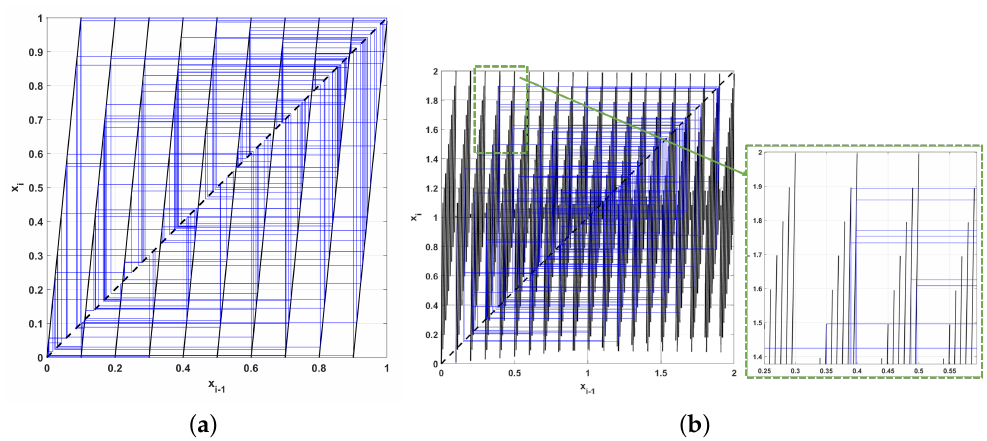
Figure 18. Cobweb diagrams for ( a ) the Renyi map (30) and ( b ) modified Renyi map (31), for k = 9.99, a = 100, N =